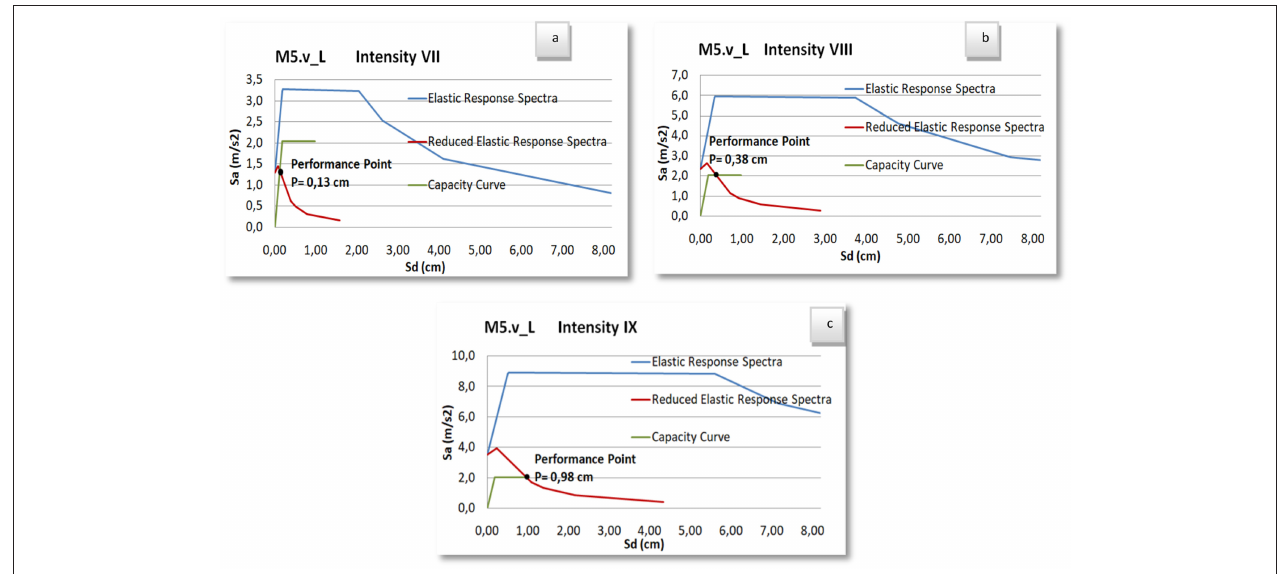
FIGURE 10 | Curve and Performance Point for intensities VII, VIII, IX.